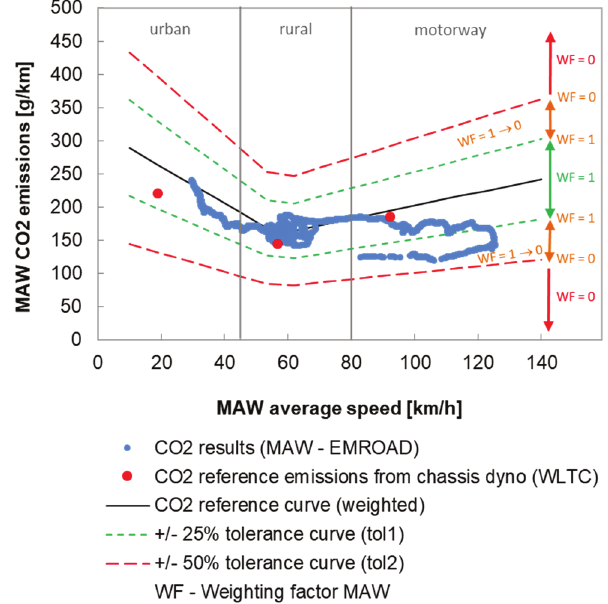
Fig. 10. Characterization of the normality and completeness of a RDE trip